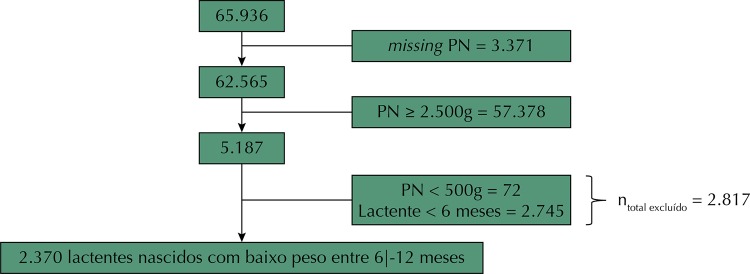
Fluxograma que representa as definições da população deste estudo.PN: peso ao nascer